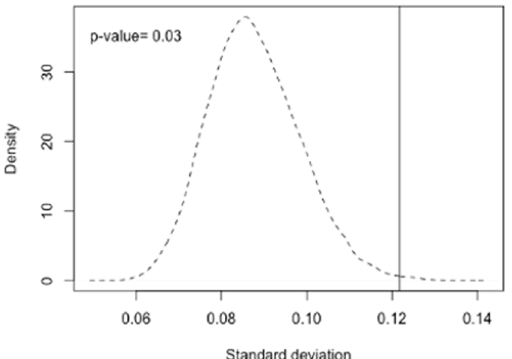
Figure 3. Permutation analysis of the deviation of MAF between different ethnic groups. We plotted the averaged distribution of standard deviation of MAF of randomly selected 39 SNPs from 6,025,429 SNPs 1000 times with a dashed line. The vertical line indicates the mean value of vitamin A related SNPs (0.121). The result suggests that deviation of the allele frequencies of the serum retinol related SNPs among different ethnicities is significantly larger than that of randomly selected SNPs ( p -value = 0.03).